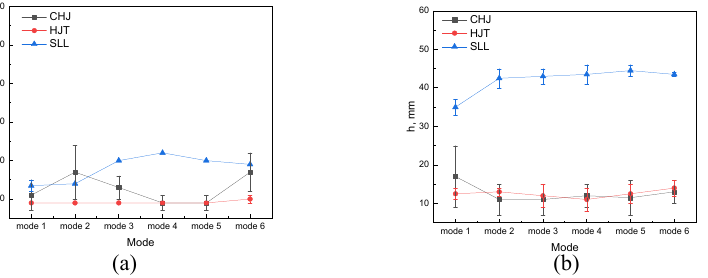
(c) Figure 11. The horizontal component of velocity at 1 mm below the liquid surface in three physical forms of the hydraulic jump (casting speed 2.4 m/min). ( a ) CHJ. ( b ) HJT. ( c ) SLL (a) (c) Figure 12. The vertical component of velocity at 1 mm below the liquid surface in three phys-